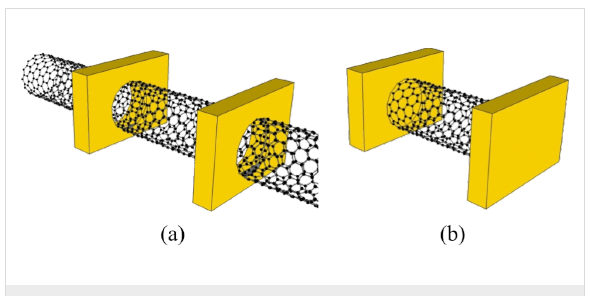
Figure 1: Contact geometries: (a) side-bonded and (b) end-bonded contact configurations.